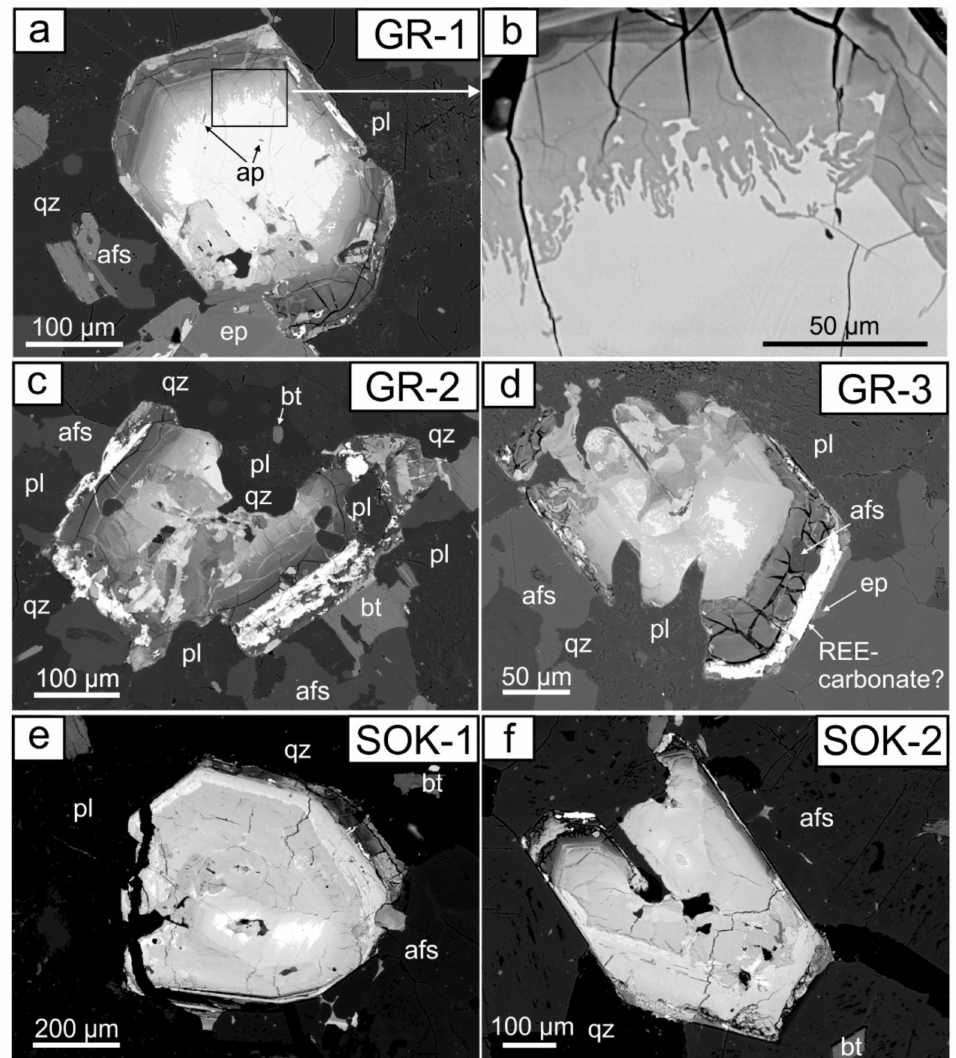
Figure 1. BSE images of the studied allanite grains. ( a ) Allanite grain GR-1 with a large preserved core, oscillatory mantle, and zones 3a, 3b, and 3c; ( b ) a close-up view of the worm-shaped contact between the core and the mantle; ( c ) allanite grain GR-2 with characteristic wavy zonation in the mantle and numerous 3b zones; ( d ) allanite grain GR-3 with small remnants of the core, the mantle, and a rim composed of zone 3b; ( e ) allanite grain SOK-1 with preserved core, the mantle, and a rim composed of zone 3a; and ( f ) allanite grain SOK-2 with the mantle and zones 3a and 3b. Mineral abbreviations are as follows: qz—quartz, afs—alkali feldspar, pl—plagioclase, ep—epidote, ap—apatite, and bt—biotite. The zones described in the text are annotated in selected grains in Figure